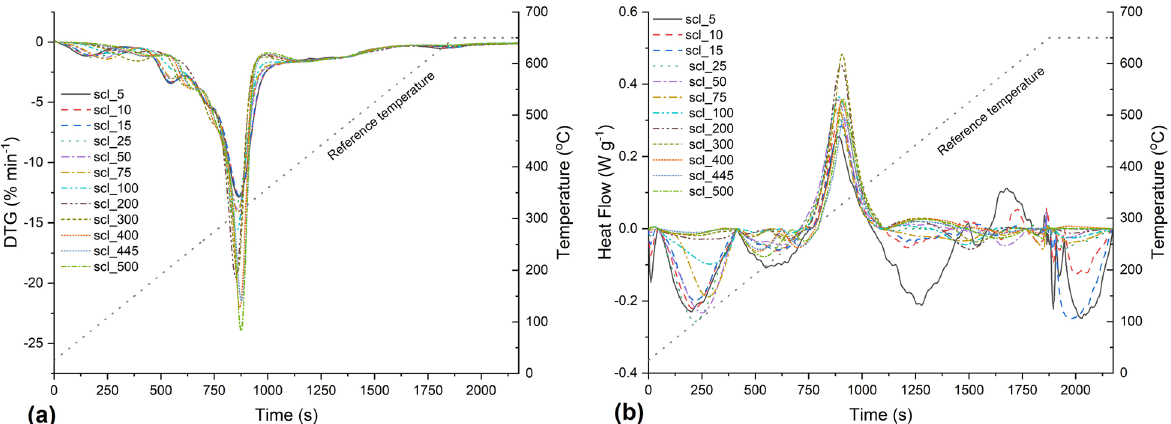
Fig. 4 Rate of mass loss ( a ) and heat flow curves ( b ) of M010 during pyrolysis at 20 °C min − 1 at different mass scales inside the TG reactor plotted against pyrolysis time. The legends scl-5, scl_10 etc., denote different mass scales inside TGA such as 5 mg, and 10 mg,